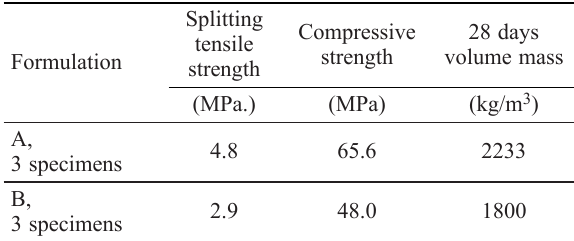
Table 3. Average strength of concrete specimens from Formulations A and B after 28 days in moist environment